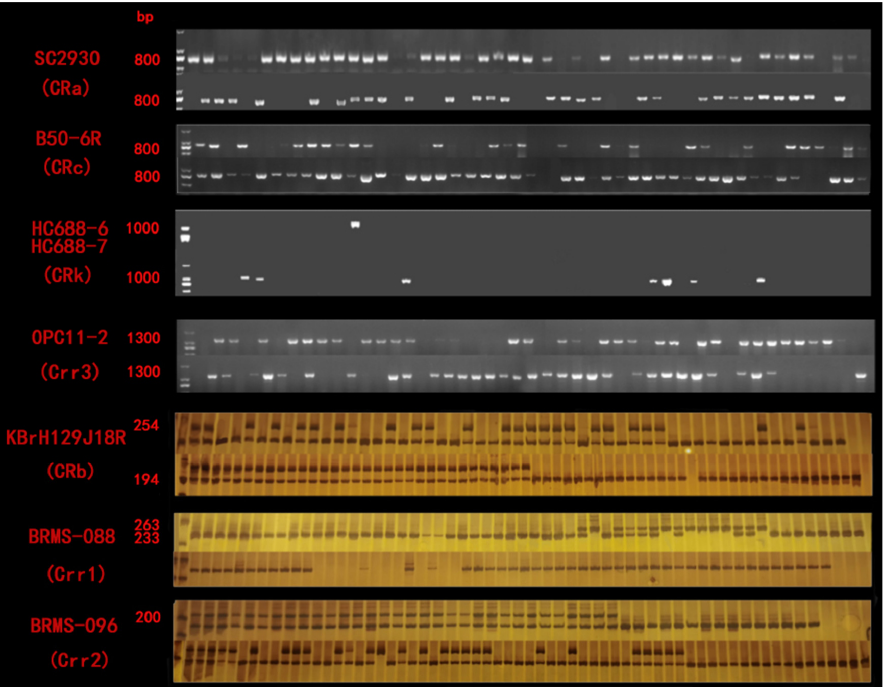
Figure 1. Amplification results of different disease resistance genes in the experimental materials. Genes 2022 , 13 , 1600